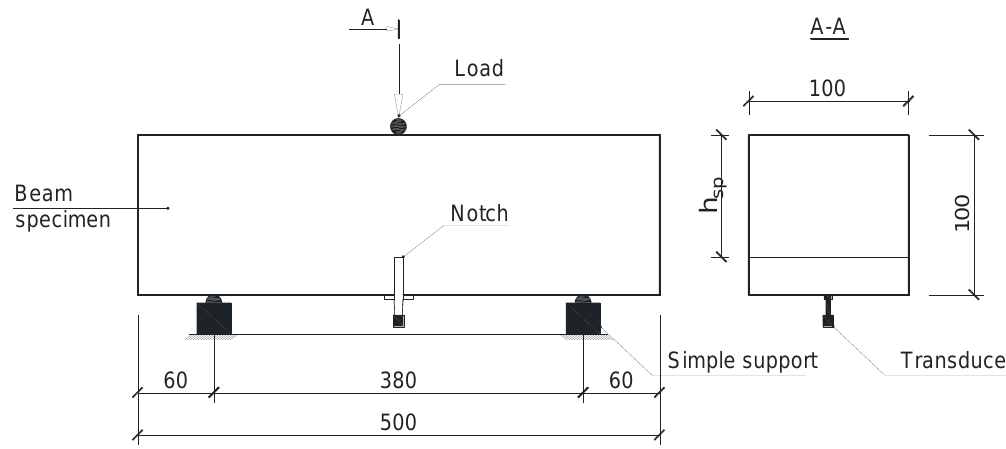
Figure 1. Dimensions and static scheme of the flexural strength test (unit: mm).